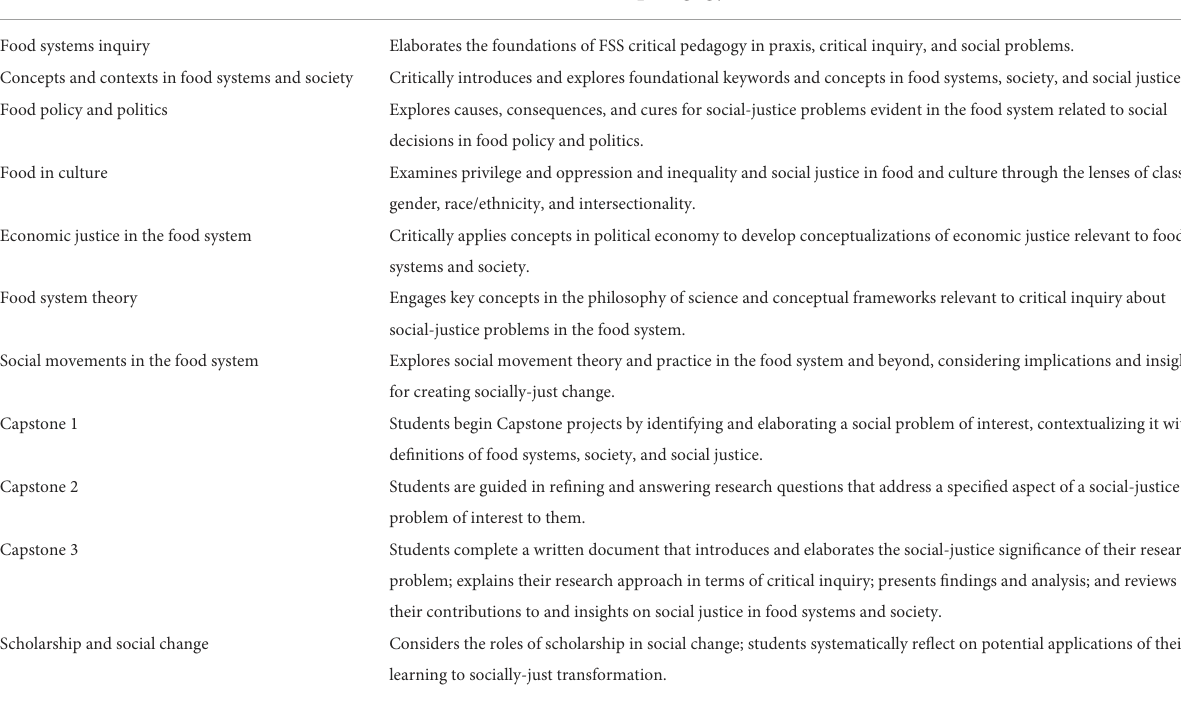
TABLE 2 Foundation and Capstone courses in the food systems and society graduate